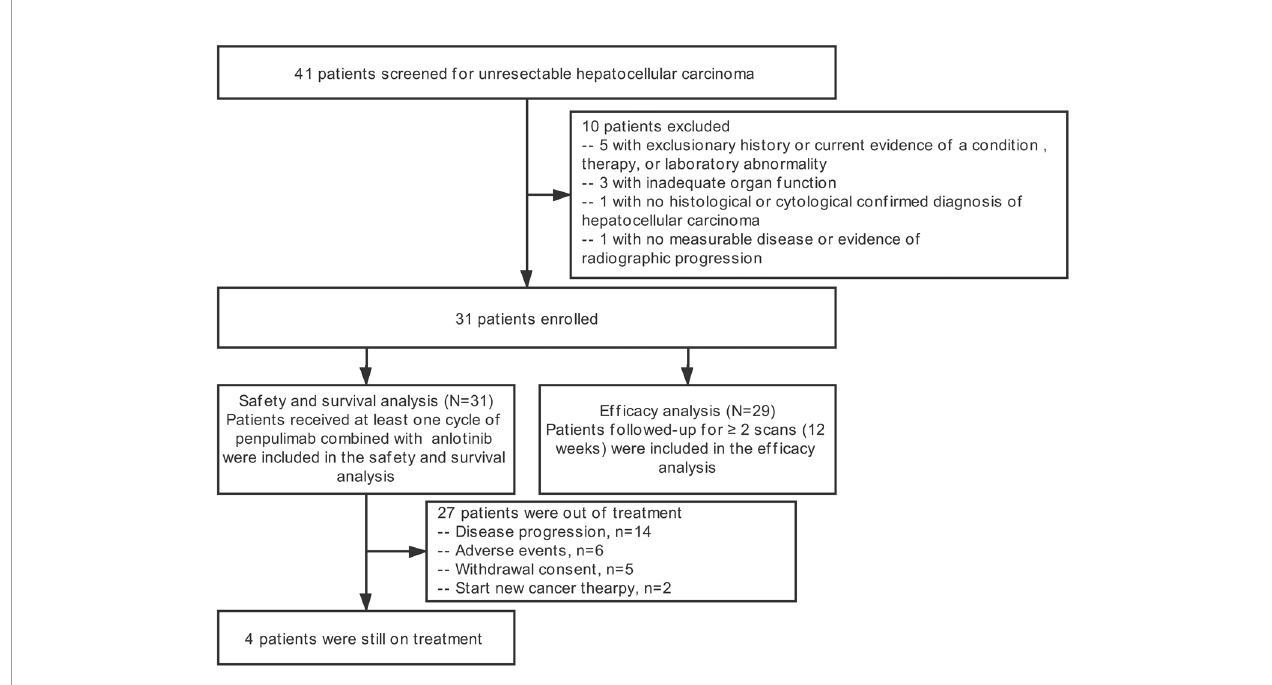
FIGURE 1 | Trial pro fi le.